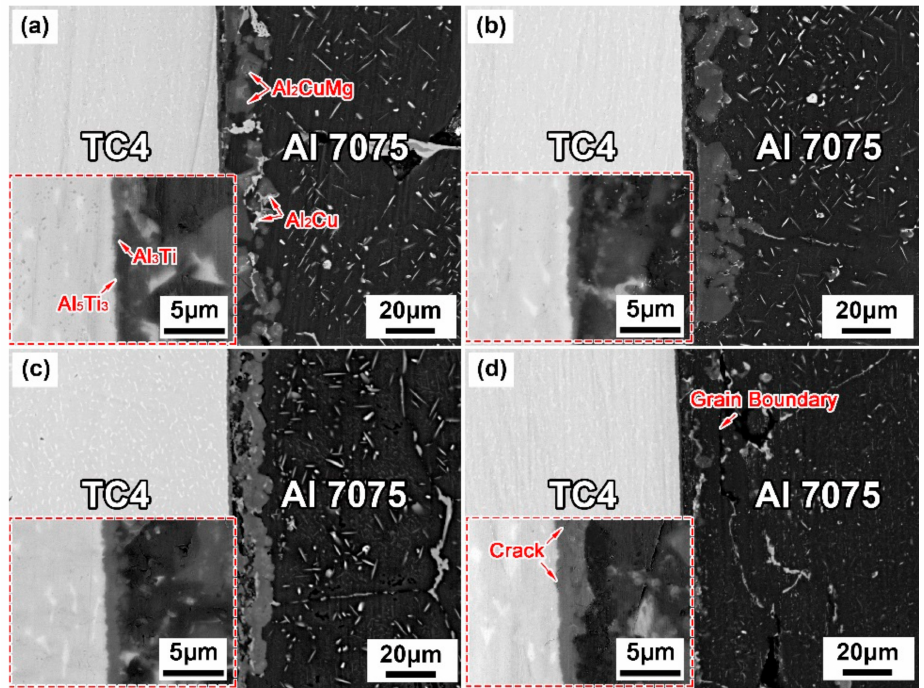
Figure 4. Interfacial microstructures of brazed joints at different temperatures for 30 min. ( a ) 560 ◦ C;